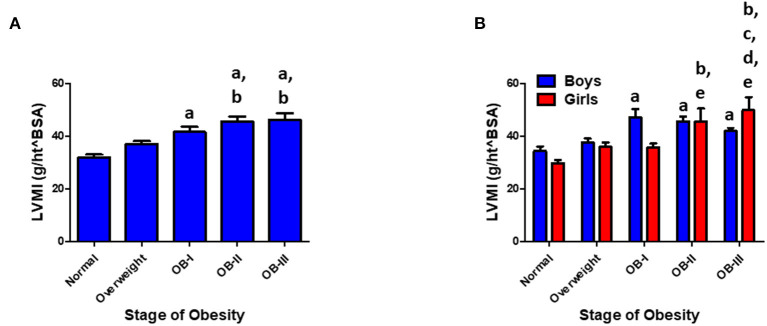
(A) LVMI increases with stage of obesity. Values are presented as mean ± SEM with One-Way ANOVA-test with Bonferroni post-hoc analysis ap < 0.001 compared to normal weight; bp < 0.001 compared to overweight group. (B) Gender and LVMI. ap < 0.001 compared to normal weight for boys. bp < 0.001 compared to normal weight for girls; cp < 0.05 compared to overweight for girls; dp < 0.05 compared to stage I obesity for girls; ep < 0.05 compared to stage II obesity for girls. Interaction between gender and obesity rank: p < 0.05.